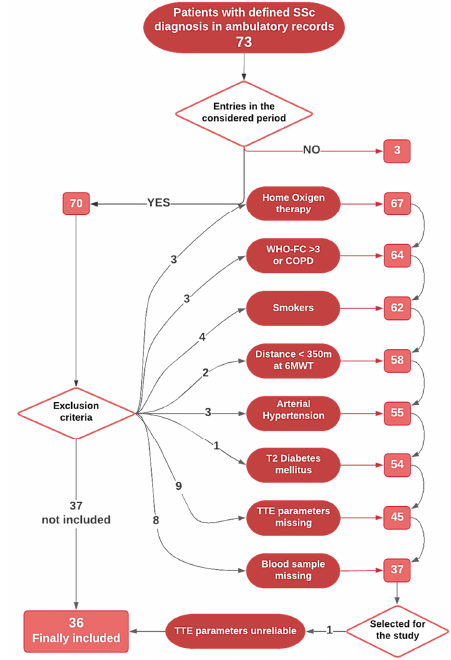
reflux were also evaluated.